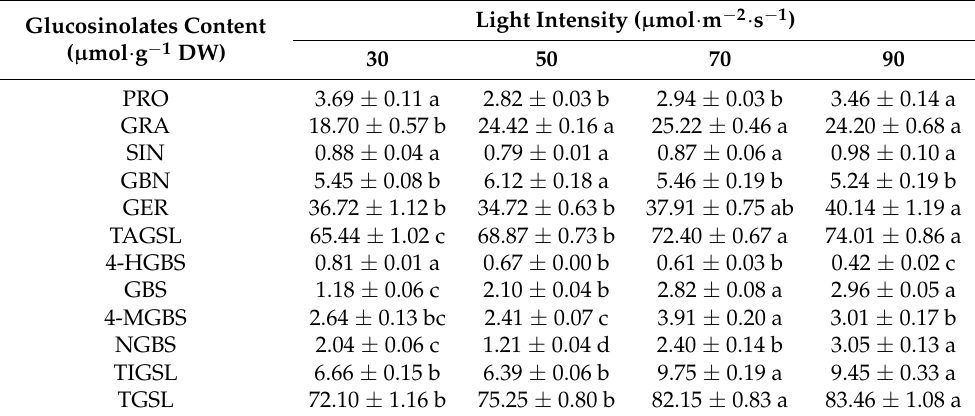
Note: Different lowercase letters in the same row show significant differences ( p < 0.05). The data were showed as means ± SE (n = 3). TAGSL, total aliphatic glucosinolate; TIGSL, total indolic glucosinolate; TGSL, total